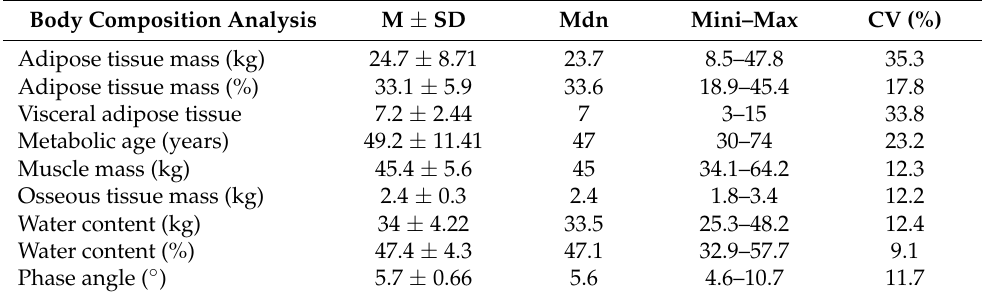
Table 4. Detailed characteristics of the body composition in the studied women (N = 191).